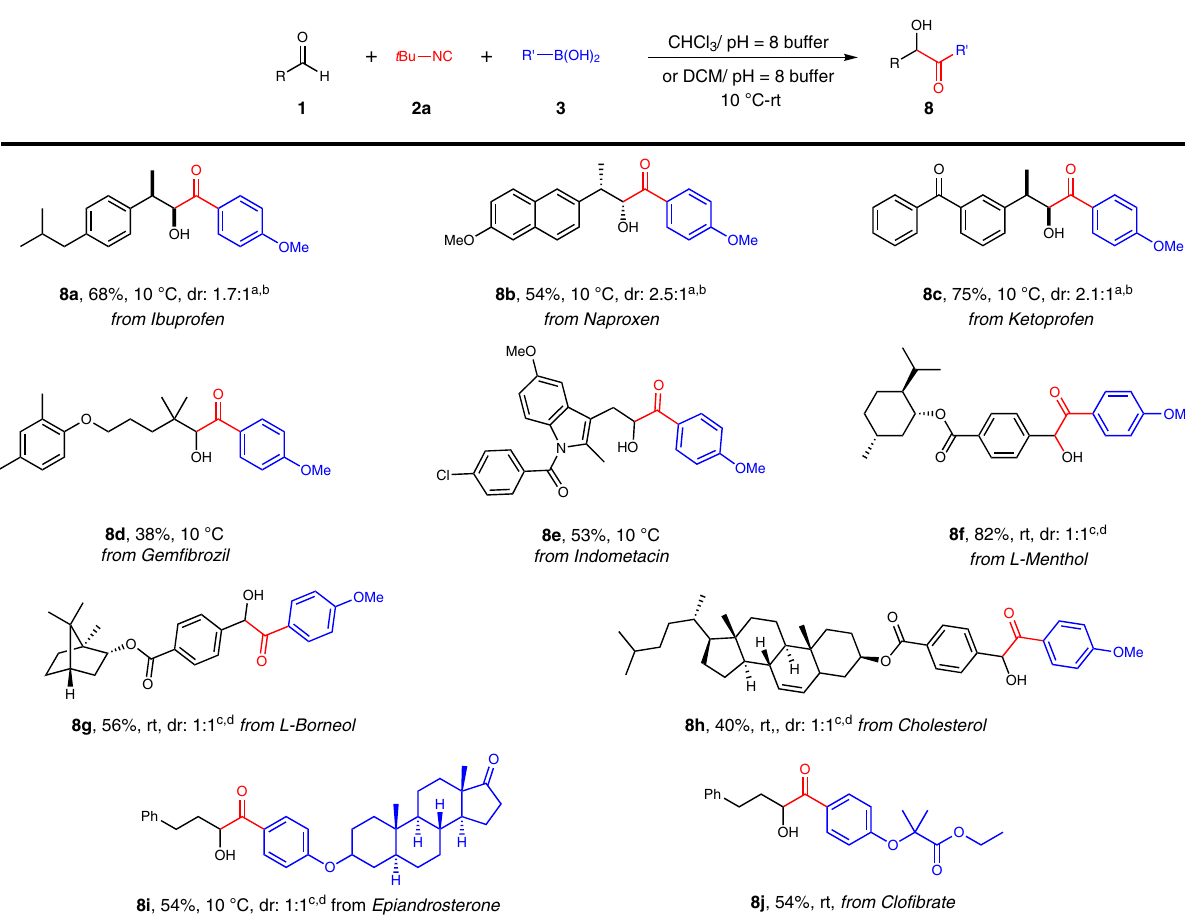
8g , 56%, rt, dr: 1:1 c,d from L-Borneol